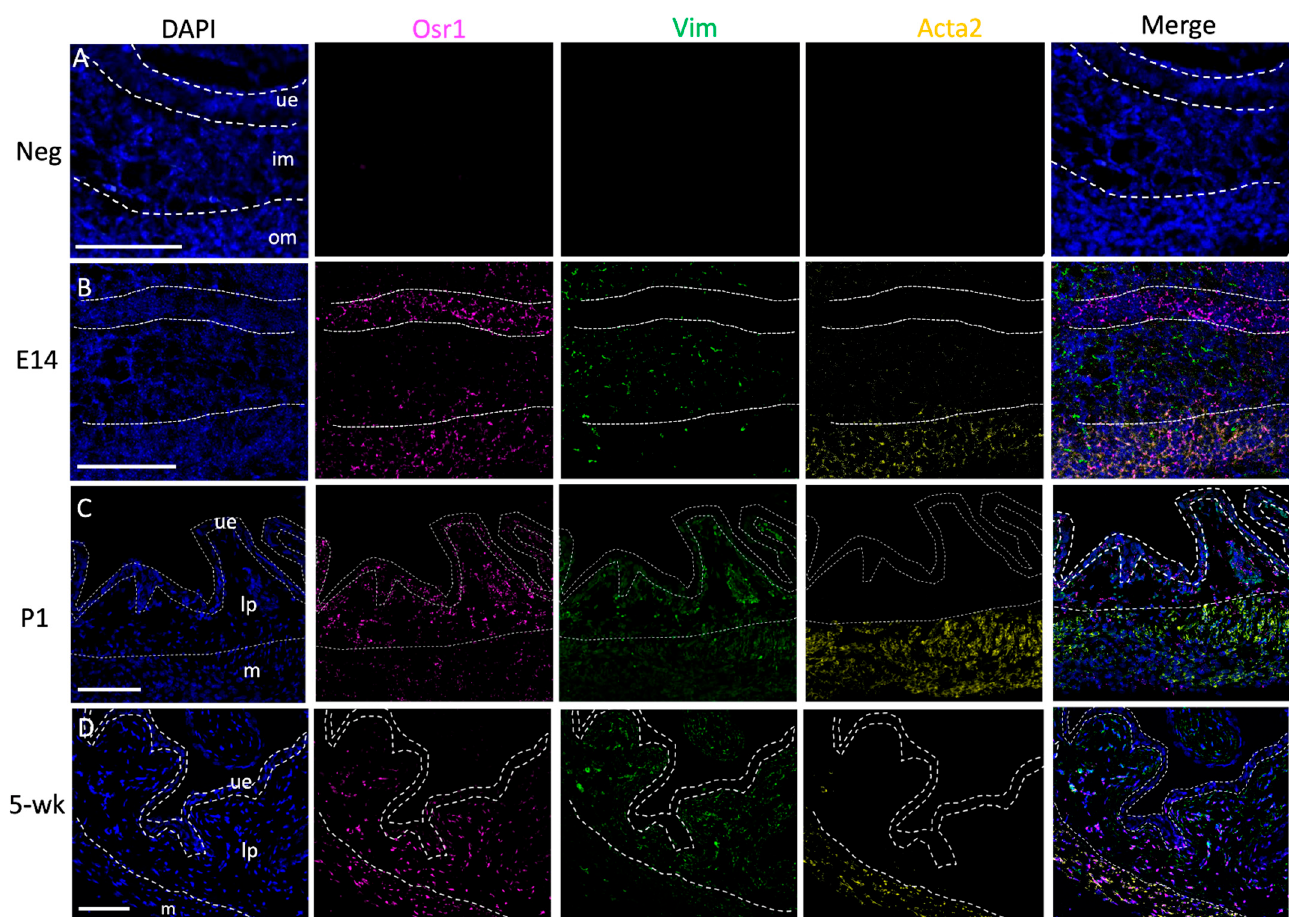
Figure 1. Osr1 shows dynamic changes in expression from the embryonic to adult bladder ( A ) Negative control using a scrambled probe ( B ) At E14 Osr1 is strongly expressed in epithelial and muscle cells and a few cells the lamina propria. ( C ) At P1 Osr1 is expressed in some cells in the epithelia, most cells in the lamina propria and muscle layer. ( D ) By five weeks of age, Osr1 is seen in most cells of the lamina propria and the majority of cells in the muscle layer. Rare epithelial cells showed expression. Odd-skipped related 1, osr1 mRNA (pink), vimentin, vim (green), alpha smooth muscle actin, acta2 (yellow), DAPI (blue). Scale bar = 100 µ m n = 3 embryo/mouse for each time-point. Dotted lines are used to demarcate the three layers of the bladder: ue = uroepithelium, im = inner mesenchyme, om = outer mesenchyme, lp = lamina propria, m = muscle.